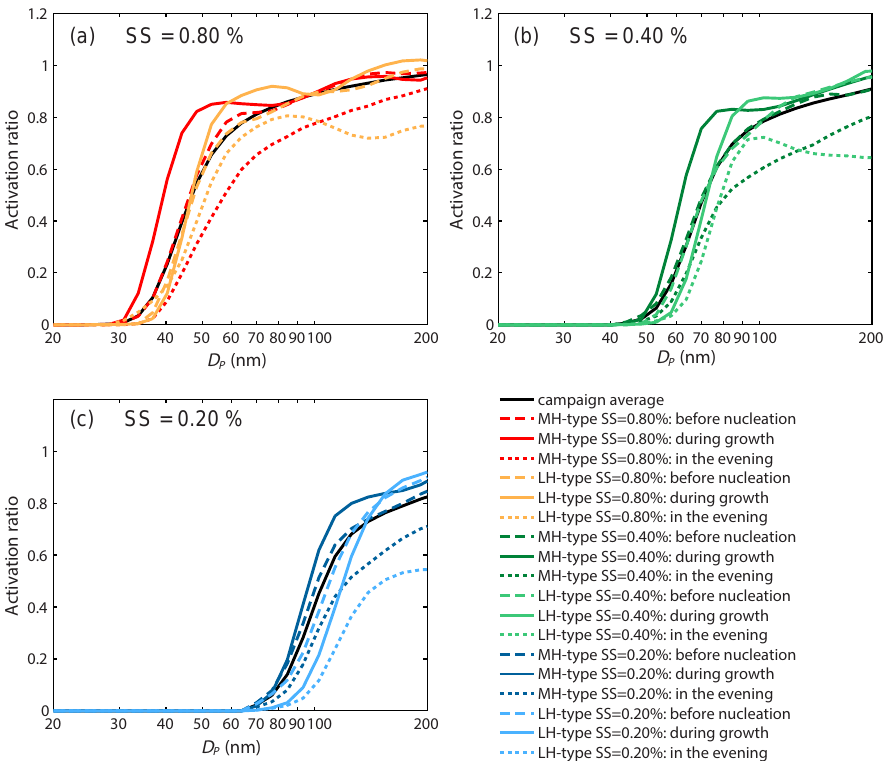
Figure 5. Average size-resolved activation ratio for the selected time periods on 22 and 24